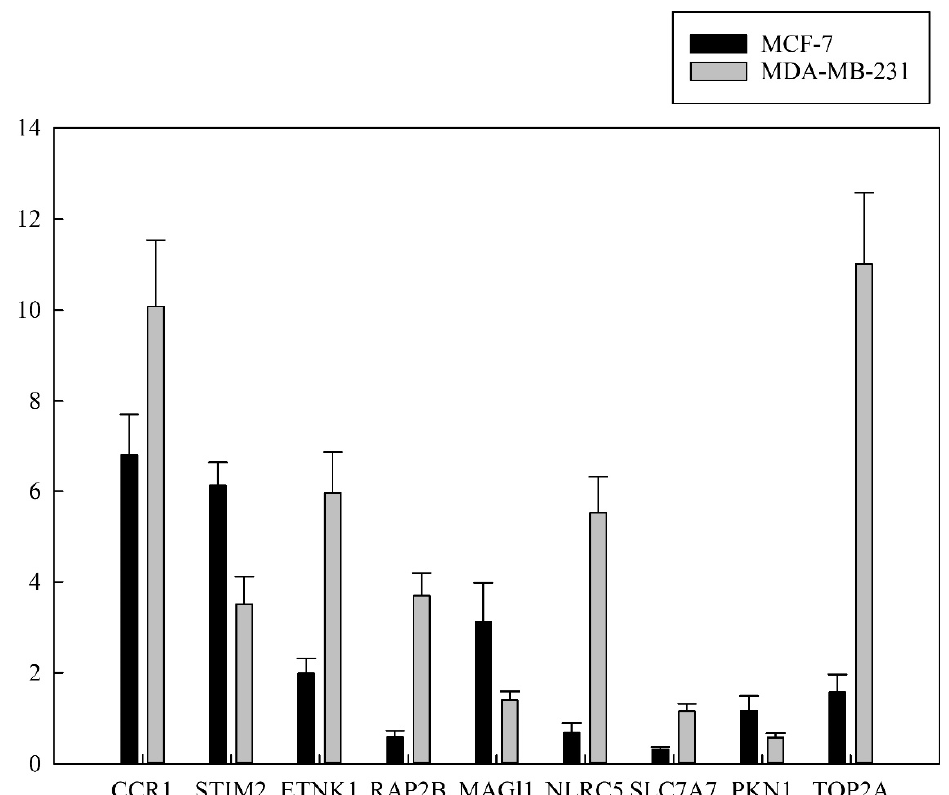
Figure 6. Validation of relative expression levels from RNA-seq and real-time polymerase chain reaction. Nine randomly selected differentially expressed genes (DEGs) were validated for the expression level from chlorophyllide-treated MCF-7 and MDA-MB-231 cells. Expression of target genes was normalized to GAPDH as a reference gene, and statistically significant differences from control are presented, with p < 0.05. The x -axis denotes nine genes. The y -axis refers to the relative expression level with the mean ± standard deviation of five replicates.